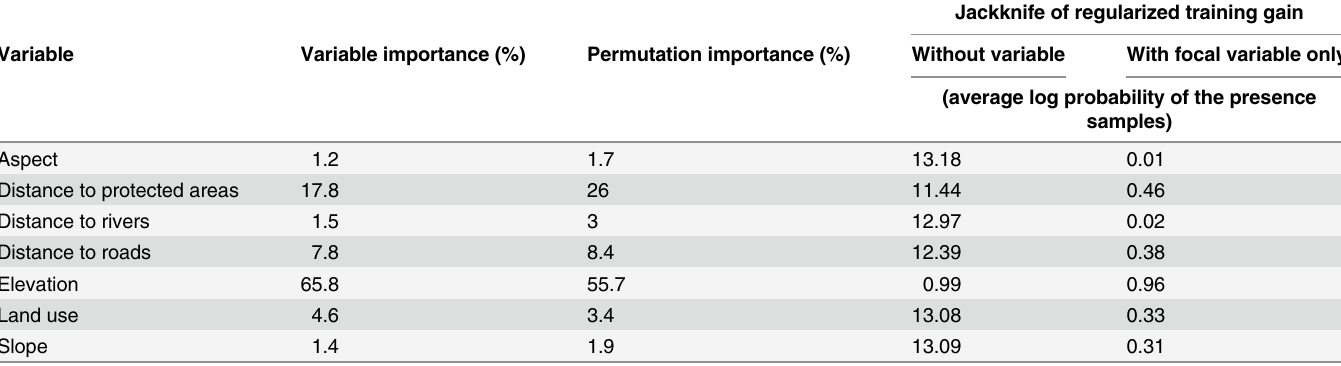
Table 1. Summary variable importance and evaluation statistics for variables included in the MaxEnt model.